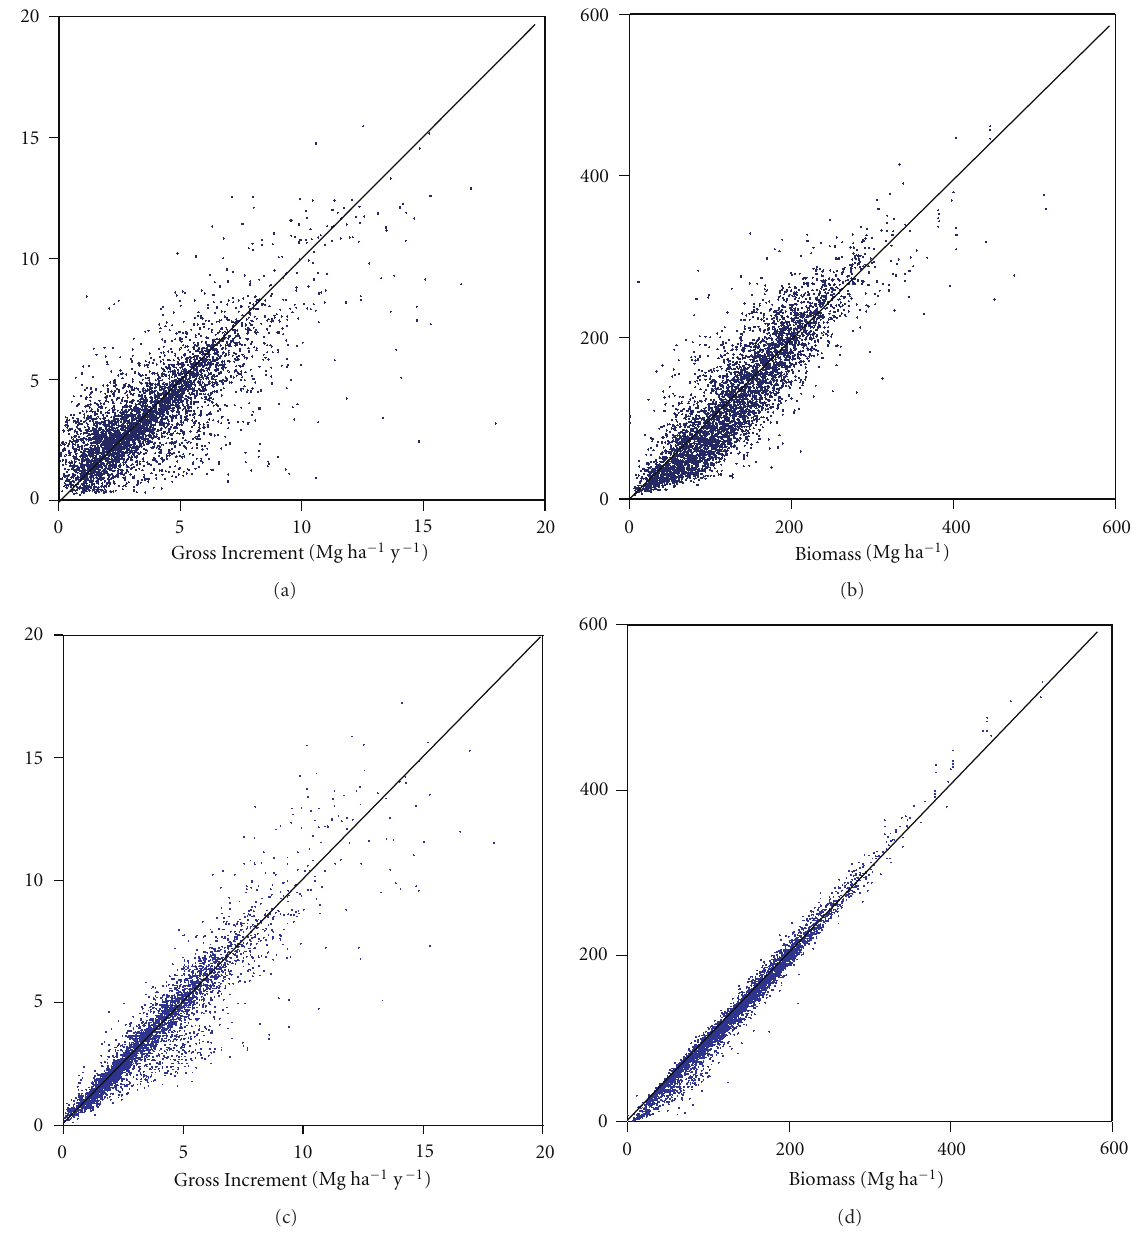
Figure 5: Modeled ( y -axis) versus measured ( x -axis) biomass (a, c) and increment (b, d) for n = 4417 European forest cohorts (defined by region, species, and age). (a, b): fitting measured volume, increment and age to a single stand closure ( c ) (model A). (c, d): fitting measured volume, increment and age to one c per age cohort (model B). In all fits a single productivity index ( p ) for each region and species was fitted for all age classes. Cross-validated percentage root mean squared error (PRMSE) was 37, 26, 30, and 22 for the models used in (a), (b), (c), and (d),